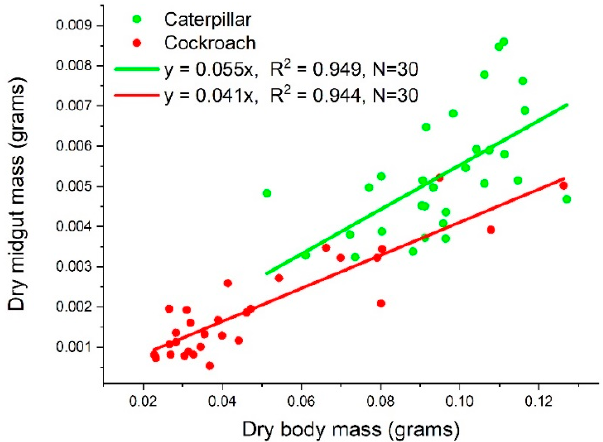
Figure 2. The dry midgut mass as linear functions of body mass of both